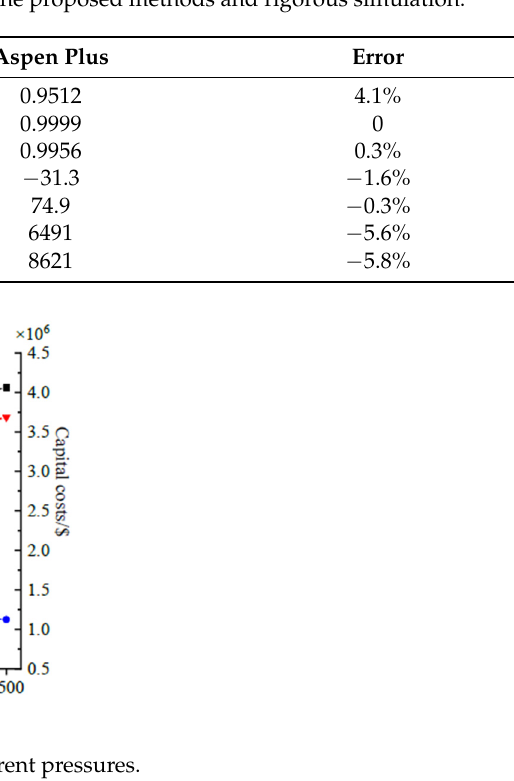
Table 4. Comparison of results obtained by the proposed methods and rigorous simulation.